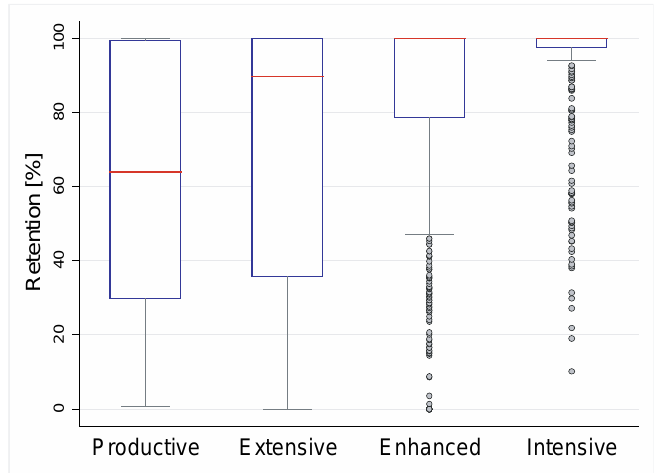
Figure 5. Effect of substrate on water retention efficiency.